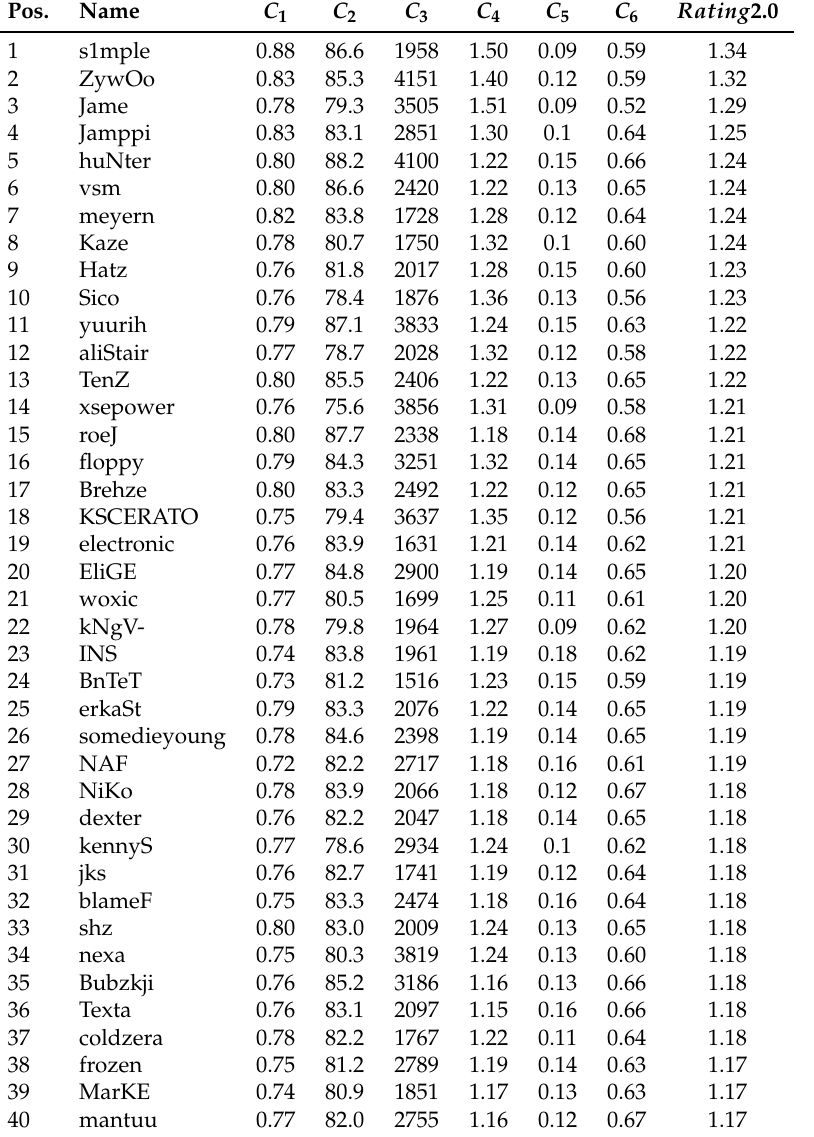
Table 11. The performance table of the alternatives, selected criteria, and reference ranking. Pos.